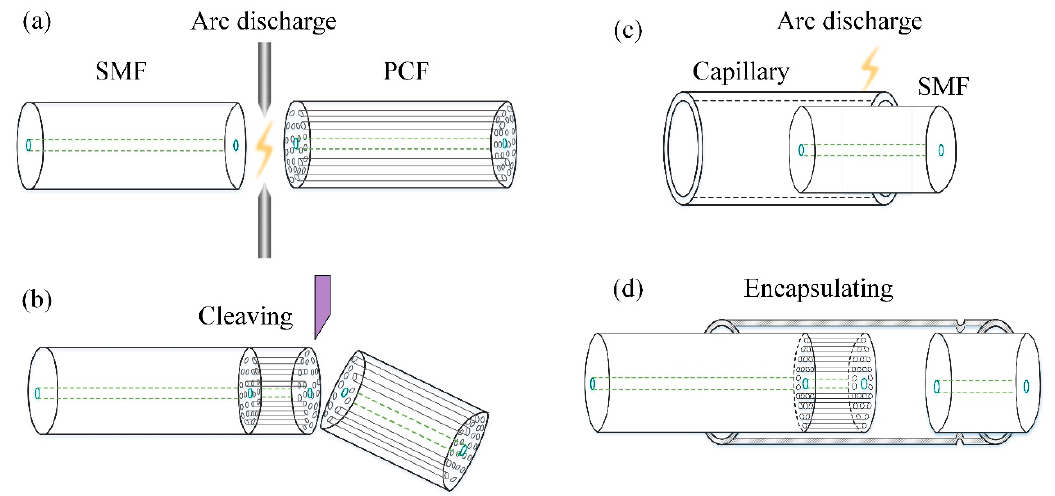
Figure 2. Schematic of the fabrication process of the CFPI sensor. ( a ) Arc fusion of the PCF to the transmission SMF; ( b ) Cleaving of the PCF to the desired cavity length; ( c ) Fusion fix of the reflective SMF to the capillary; ( d ) Alignment and encapsulation of the CFPI sensor.